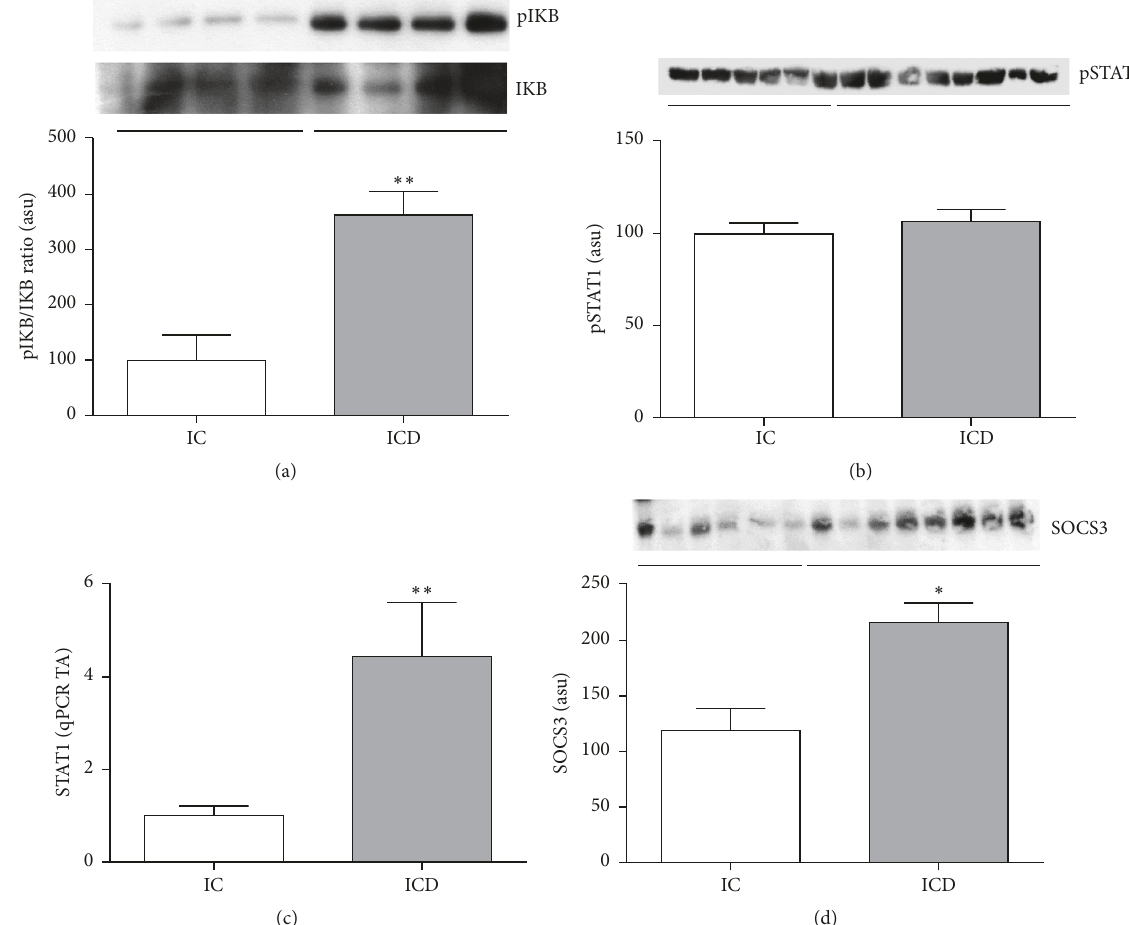
Figure 4: Intestinal mucosa of Crohn’s disease patients shows inflammation driven by NF-KB. Higher SOCS3 protein expression counterbalances the STAT1 activation. Western blot analysis of pI 𝜅 B/I 𝜅 B ratio (a), pSTAT1 (b), and SOCS3 (d) in intestinal mucosa of CD patients (ICD Group) compared to controls (IC Group). mRNA levels (qRT-PCR) of STAT1 (c) in intestinal mucosa of CD patients (ICD Group) compared to controls (IC Group). Each band represents one patient. For ICD, 𝑛 = 10 ; for IC, 𝑛 = 8 ; ∗ 𝑝 < 0.05 , ∗∗ 𝑝 < 0.01 , and ∗∗∗ 𝑝 < 0.001 versus control. ASU: arbitrary scanning unit; TA: transcription